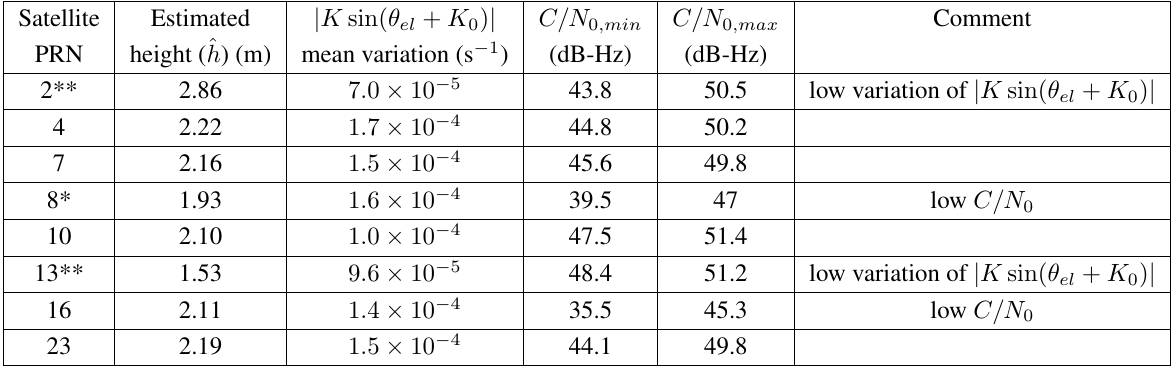
Calibration step Estimation step Table 4. 17 January 2014, at 14h09 UTC. Reference height: h = 2 . 13 m, ∆ x = 1 . 92 m. Satellite